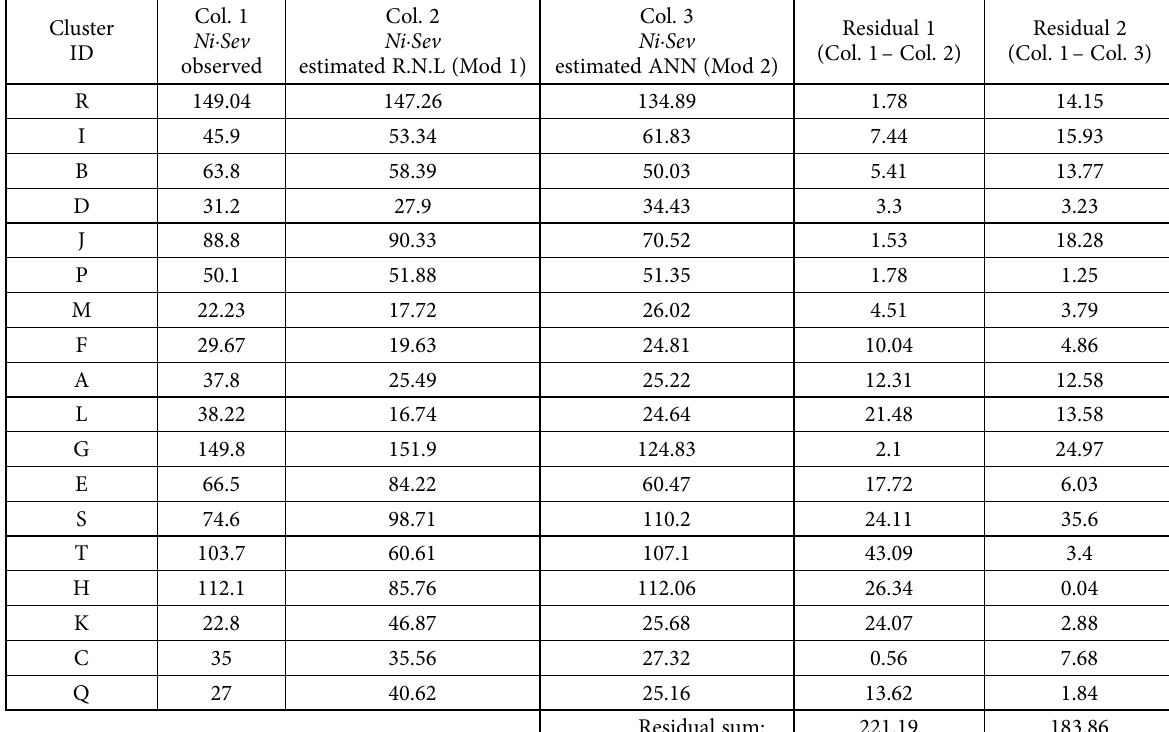
Table 7. Comparison